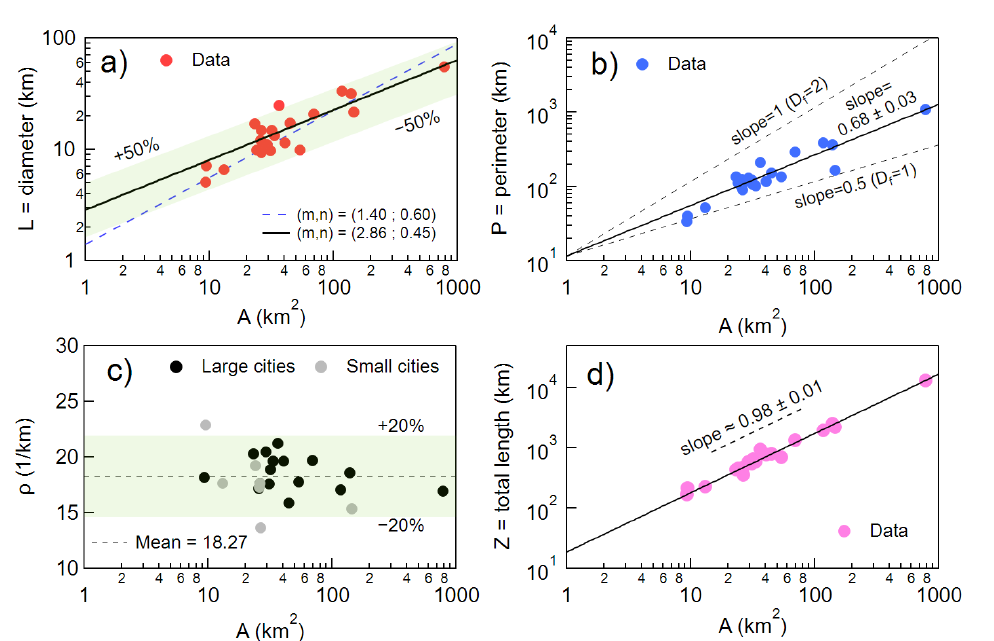
Figure 9. Allometry of Chilean cities. Relationship between area A and ( a ) the diameter of each network L , ( b ) the envelope perimeter P , ( c ) the the linear density ρ and ( d ) the total length of each network Z . Shadowed regions (in green) are arbitrary scattering bands. Continuous lines are power-law fitting functions to